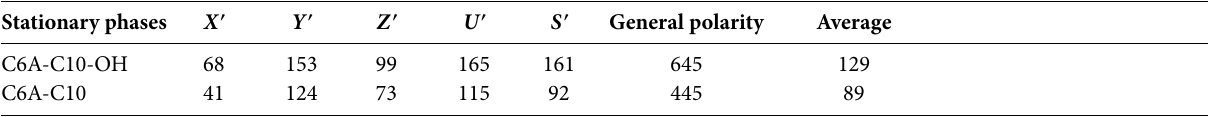
Table 4. McReynolds constants of the C6A-C10-OH and C6A-C10 columns Stationary phases